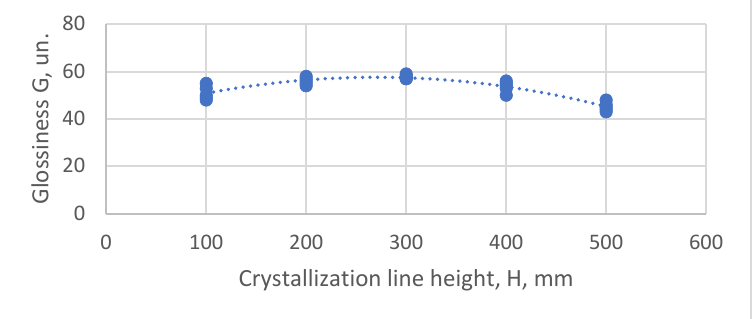
Figure 15. Dependence of the friction coefficient on the cooling temperature of the extruder head.